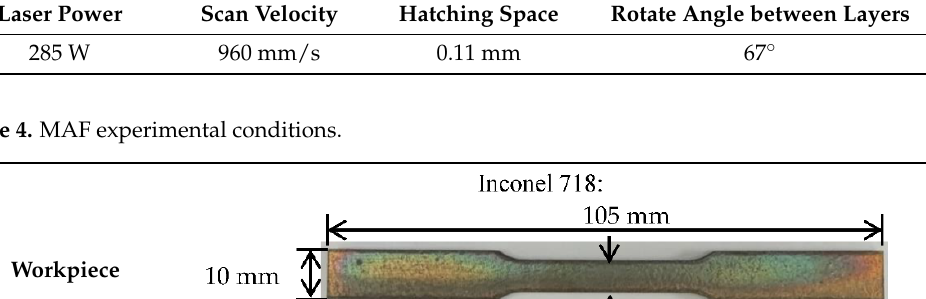
Table 3. LPBF printing parameters of Inconel 718 used in this work.